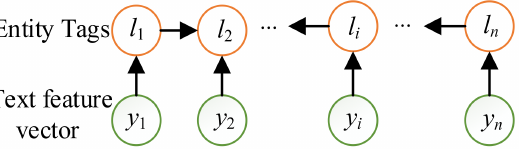
Figure 7. Entity marking algorithm diagram based on